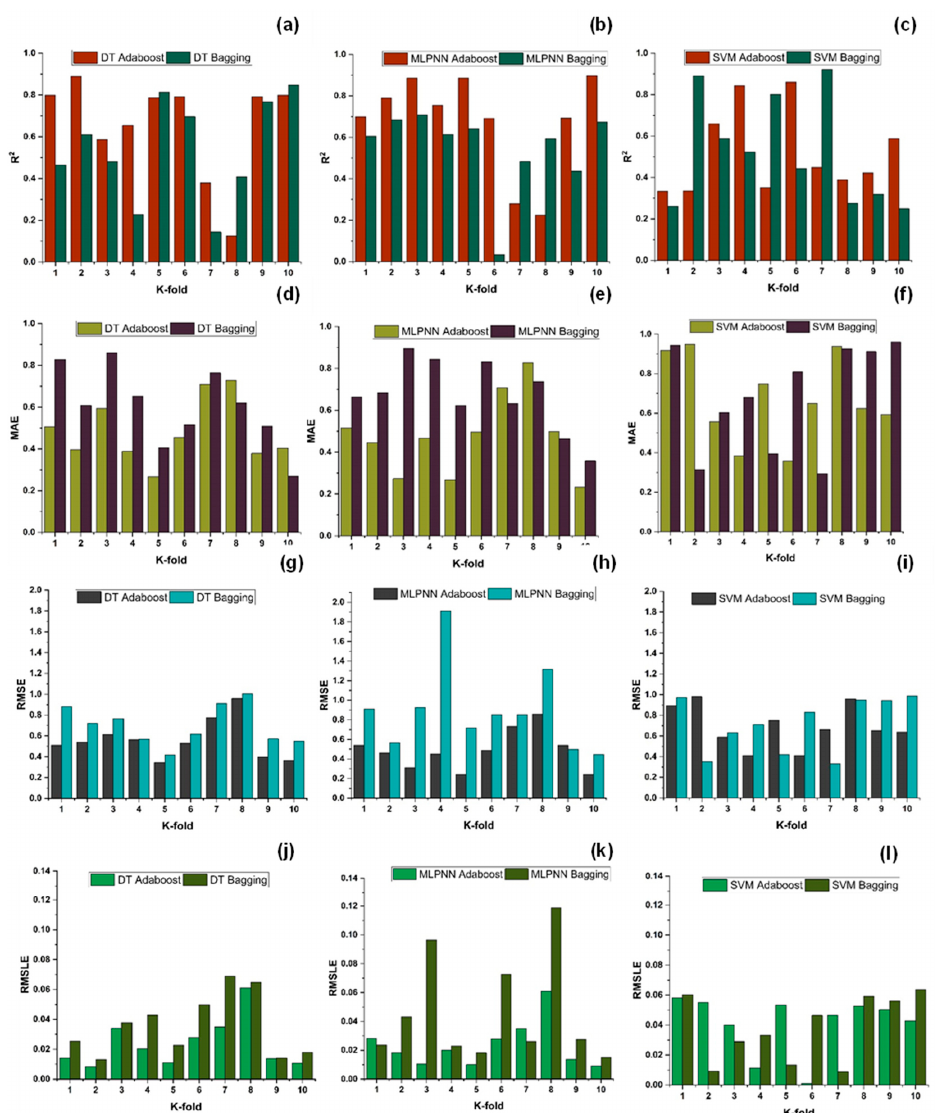
Figure 25. Tensile strength models ( a – c ) indicates R 2 models’ result validated with K fold; ( d – f ) indicates MAE models’ result validated with K fold; ( g – i ) indicates RMSE models’ result validated with K fold; ( j – l ) indicates RMSE models’ result validated with K fold.